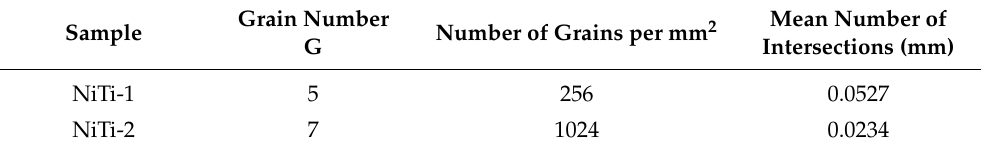
Figure 3. Micrographs of grains and boundaries (500 um scale): ( a ) NiTi-1 sample; ( b ) NiTi-2 sample. Table 2. ASTM analysis results. Table 2. ASTM analysis results.